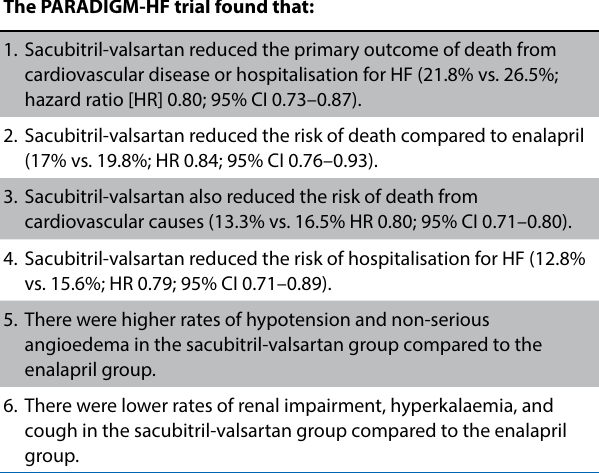
The PARADIGM-HF trial found